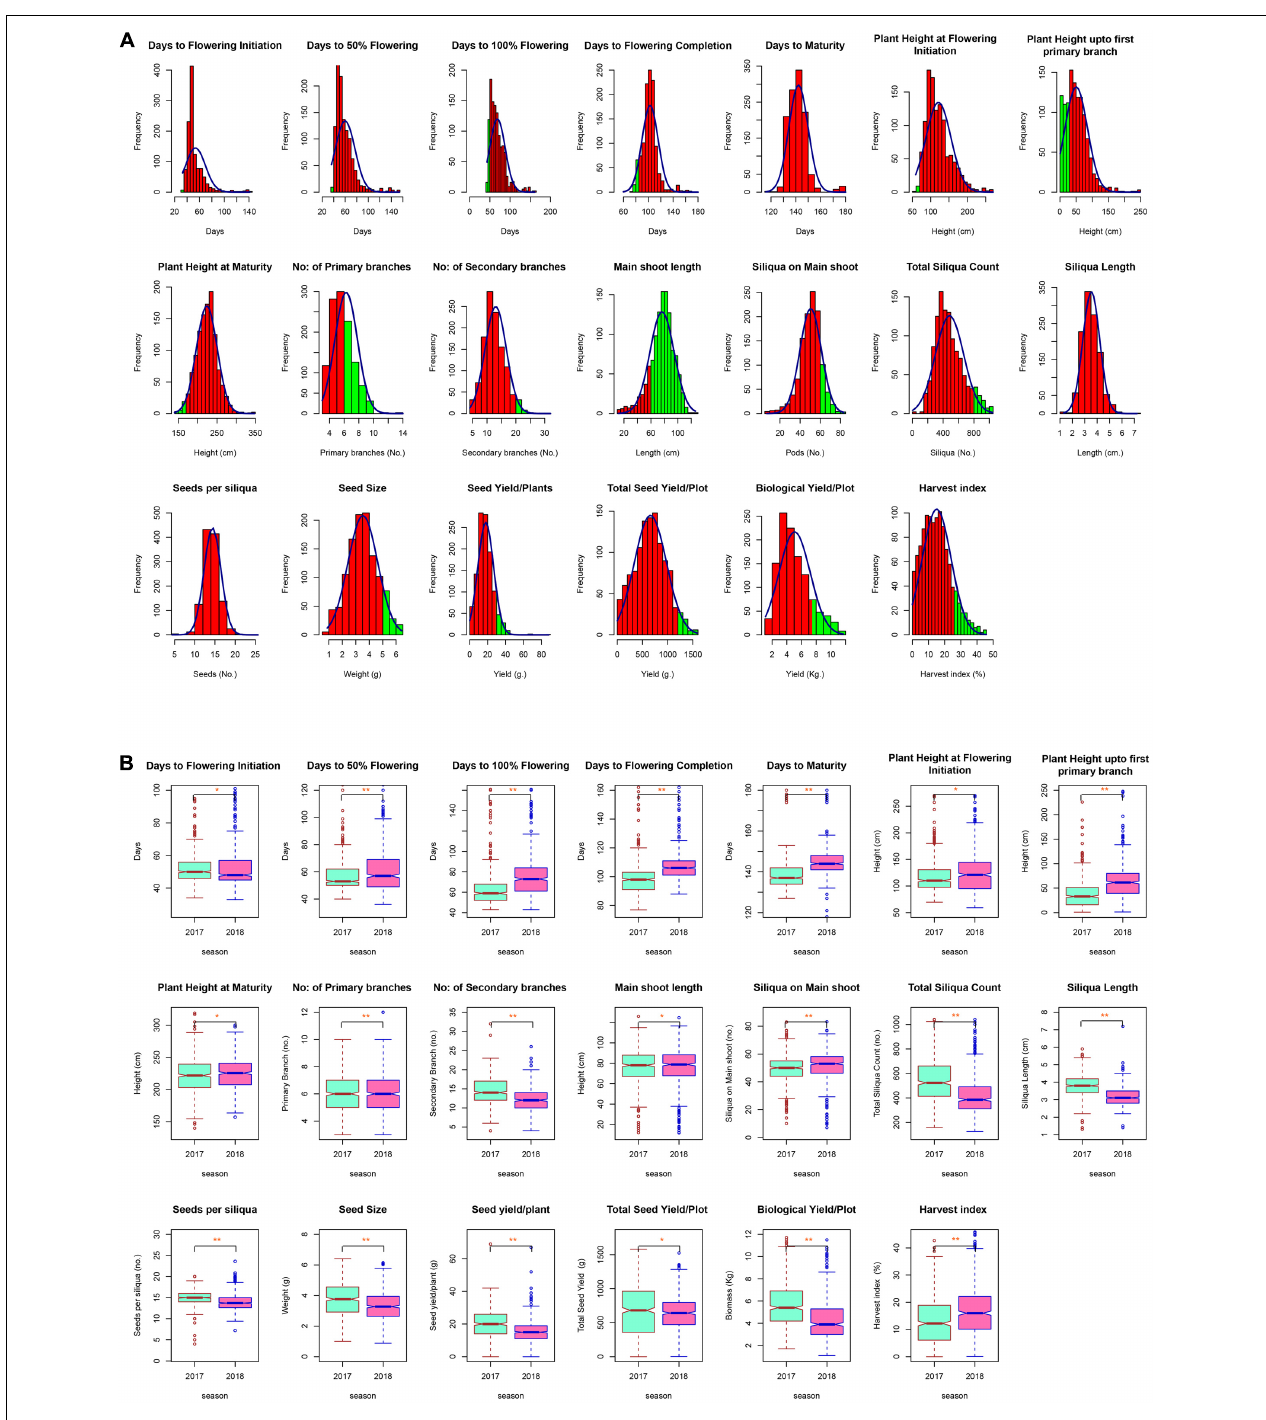
FIGURE 2 | (A) Histogram showing distribution of different agro-morphological traits across the diversity panel. Acceptable values for each trait were chosen based on various ideotype concepts given for oilseed Brassica , and acceptance region was indicated by green region on the histogram. (B) Notched box plots showing difference of 20 traits contributing to grain yield during 2017–2018 and 2018–2019 in New Delhi. Box edges represent upper and lower quartile, with median value shown as a bold line in the middle of the box. Whiskers represent 1.5 times the quartile of the data. Individuals falling outside the range of the whiskers shown as open dots. Boxplot obtained between seasons for each trait was compared using Wilcoxon statistic, and corresponding level of significance was shown by p -values in codes (** p ≤ 0.01, * p ≤ 0.05, NS, not significant).